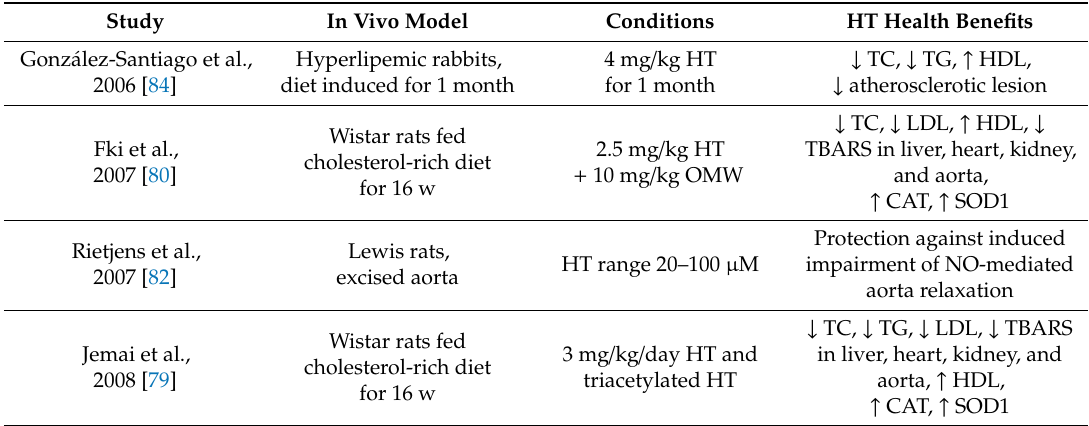
Table 2. Summary of relevant studies on HT supplementation in animal models and obtained e ff